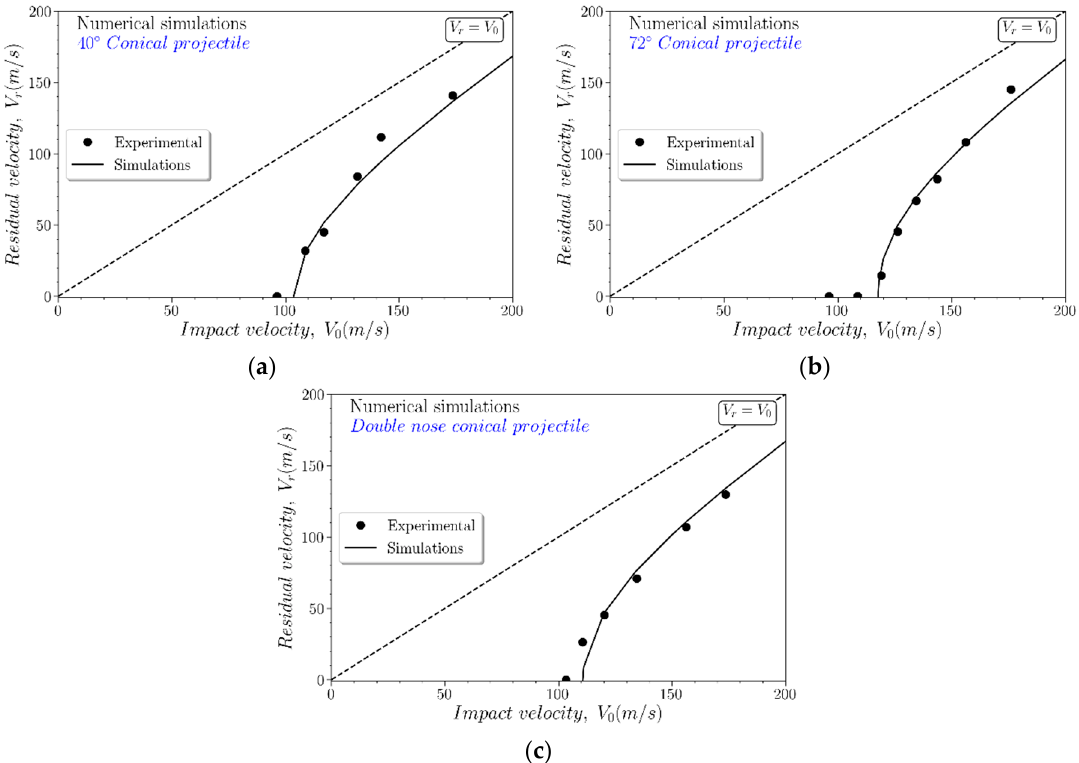
Figure 8. Experimental and numerical ballistic curves for ( a ) 40° conical projectile, ( b ) 72° conical projectile, and ( c ) double-nose projectile.